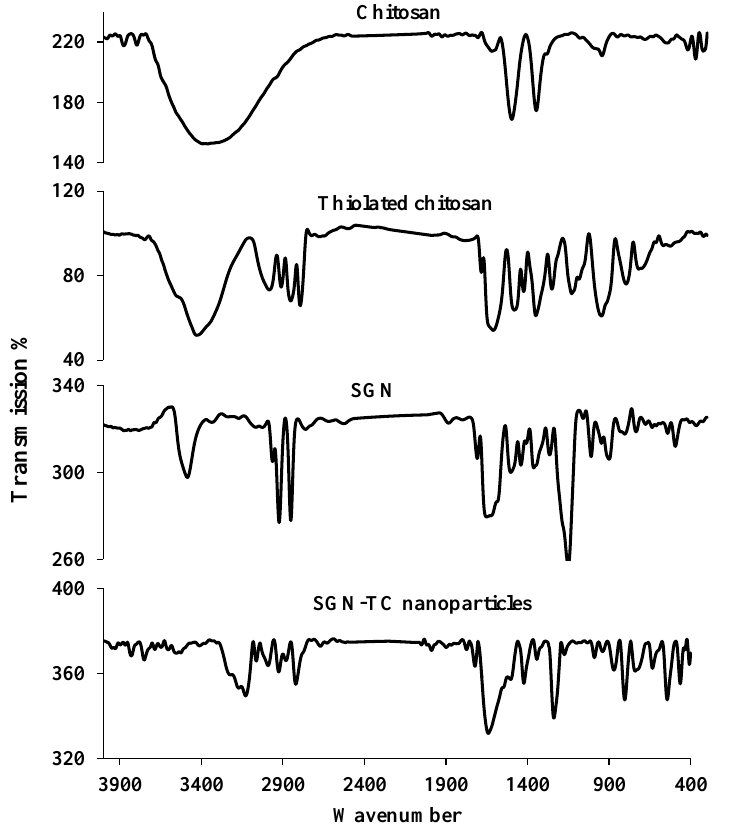
Figure 6. Fourier transform infrared spectroscopy (FTIR) of chitosan, thiolated chitosan, SGN, and SGN–TC nanoparticles.